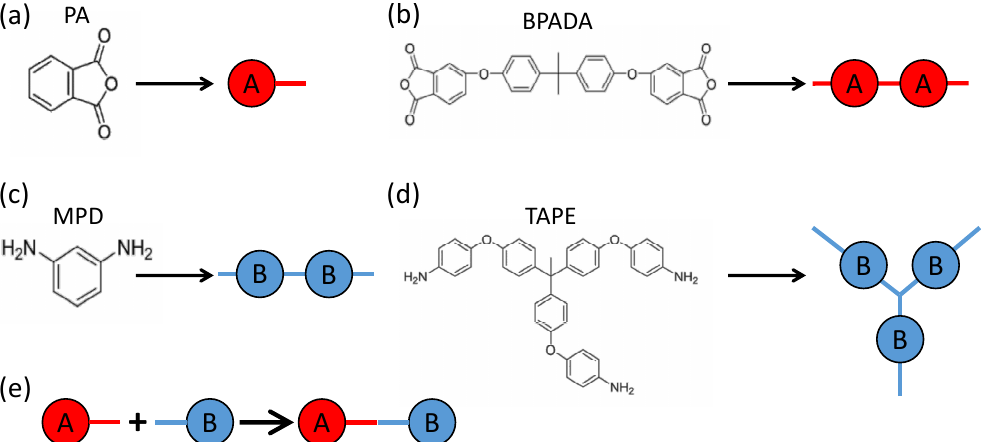
Figure 1. ( a – d ): The representation of the four types of monomers of the branched PEIs in the MC simulation model. Each functional group containing one amine is mapped to a B bead. Each functional group containing one carboxylic anhydride is mapped to an A bead. ( e ): Each A bead can form a bond with a B bead, mimicking the condensation reaction between an amine group and a carboxylic anhydride group in the polymerization of